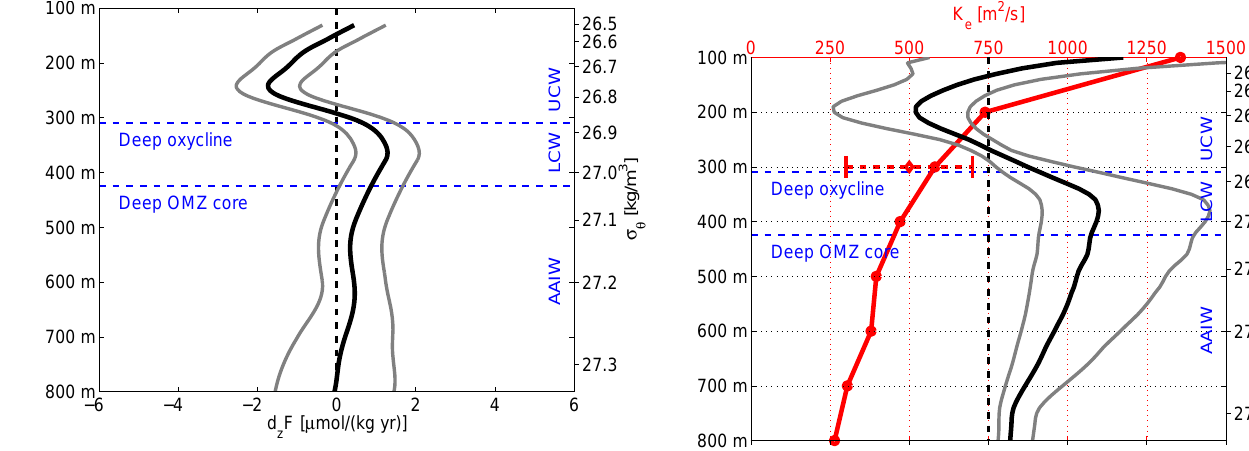
Figure 13. Mean oxygen supply due to diapycnal mixing (solid black line) for the open ocean ETNA OMZ and 95% confidence error level (solid grey lines) as function of depth (left axis) or po- tential density (right axis). Blue dashed lines mark the depths of the deep oxycline and of the core of the deep OMZ that separate layers of upper and lower CW, and AAIW.